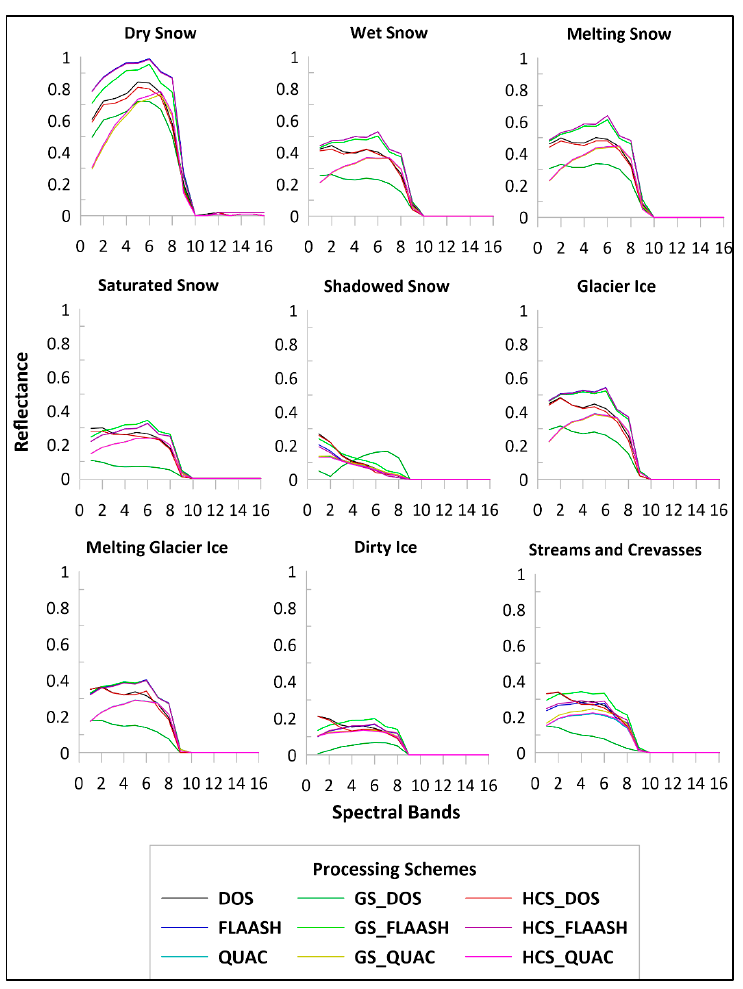
Figure 3. Difference in spectral response of facies in Svalbard for the processing schemes. 2: Band 2 = Blue; 4: Band 4 = Yellow; 6: Band 6 = Red Edge; 8: Band 8 = NIR 2; 10: Band 10 = SWIR 2; 12: Band 12 = SWIR 4; 14: Band 14 = SWIR 6; 16: Band 16 = SWIR 8.